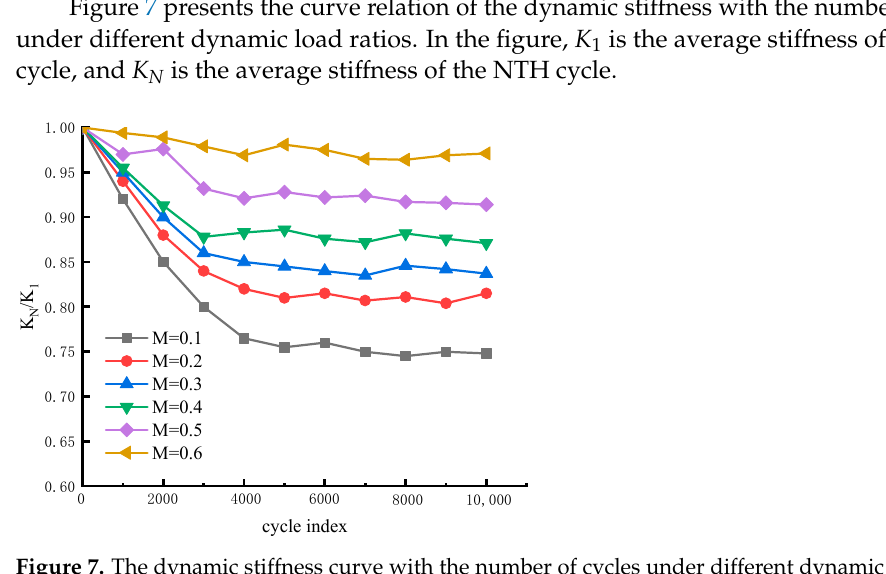
Figure 7. The dynamic stiffness curve with the number of cycles under different dynamic load